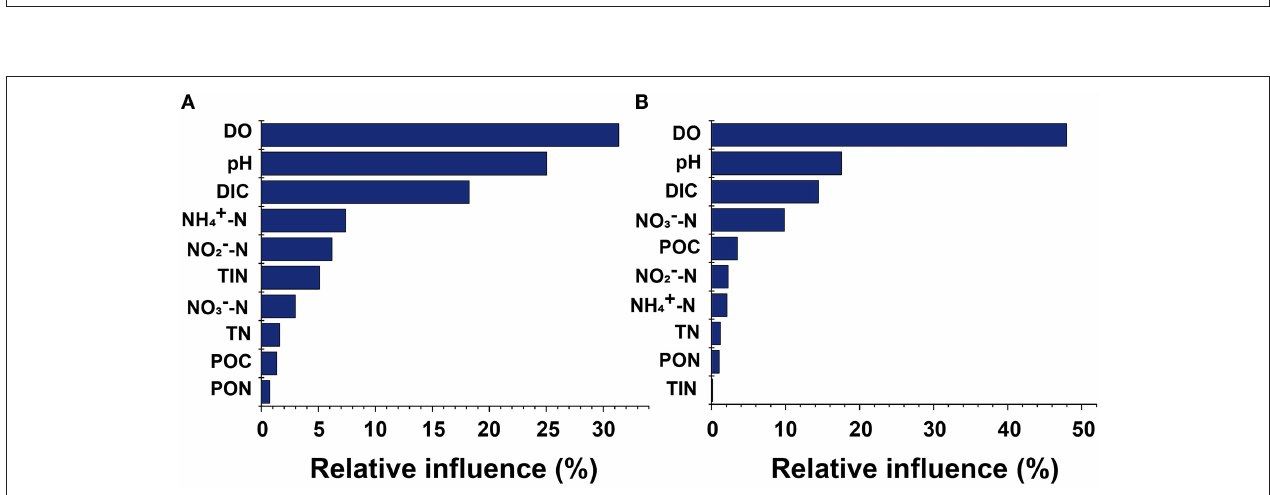
FIGURE 5 | Correlation analysis between environmental parameters and N 2 O potential production for (A) the Dongjiang port and (B) the Hongxing wharf. Circle colors and sizes represent Pearson’s correlation coefficients (r). *, **, and ***indicate significance levels at p < 0.05, p < 0.01, and p < 0.001, respectively. DIC, dissolved inorganic carbon; DO, dissolved oxygen; POC, particulate organic carbon; PON, particulate organic nitrogen; TN, total nitrogen; TIN, total inorganic nitrogen.